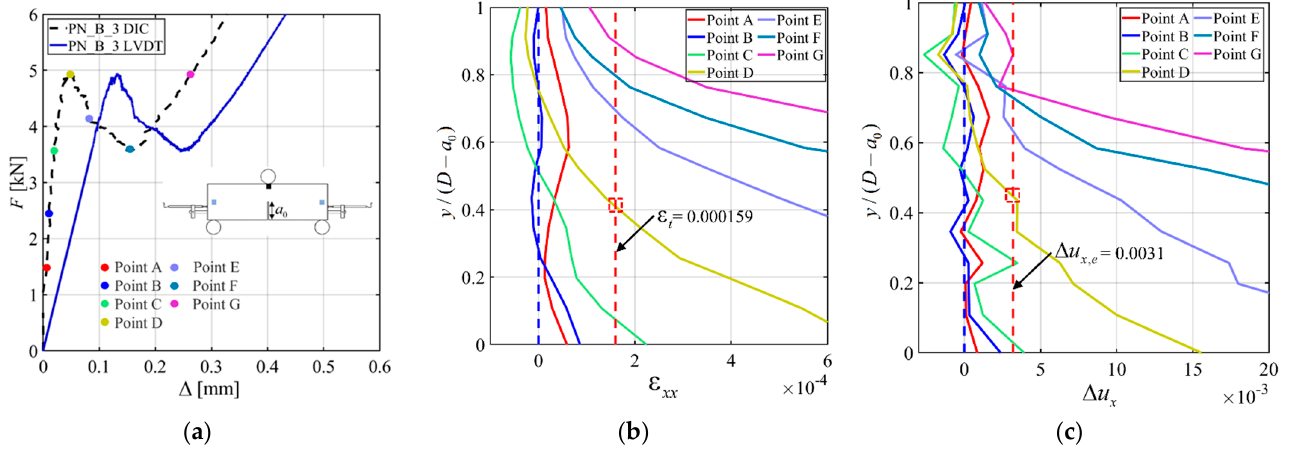
Figure 11. ε t and Δ u x profiles for PN_B_3: ( a ) Loading points shown in colored circle for ε xx and Δ u x ; ( b ) ε xx profile; and ( c ) Δ u x profile. ( b ) ε xx profile; and ( c ) ∆ u x